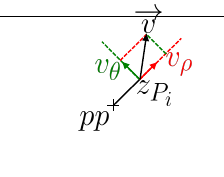
Figure 2. Decomposition of the departure from collinearity vector, (cid:126)v P into its radial ( v ρ ) and orthoradial ( v θ ) components i for a tie-point observed at image coordinates z P